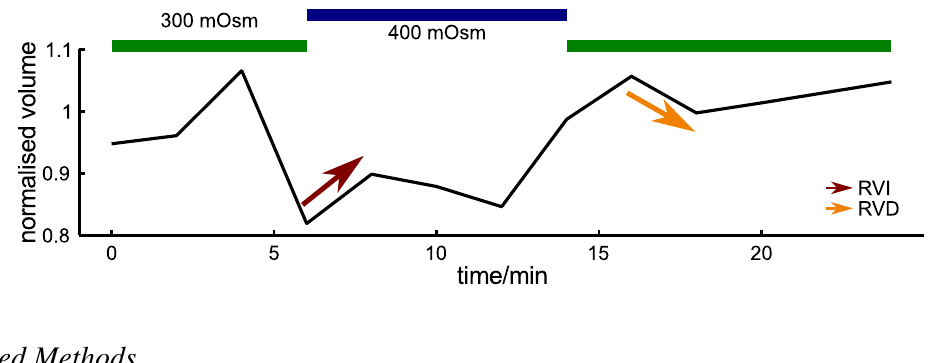
Figure 10. Volume changes of a rat hepatocyte after exposure to hyperosmotic solution. Hepatic cells cultured and superfused with solutions as described in [67,68]. RVI: regulatory volume increase, RVD: regulatory volume decrease. Step sizes were 2 µ m lateral and 100 nm vertical, probe resistance was approximately 5